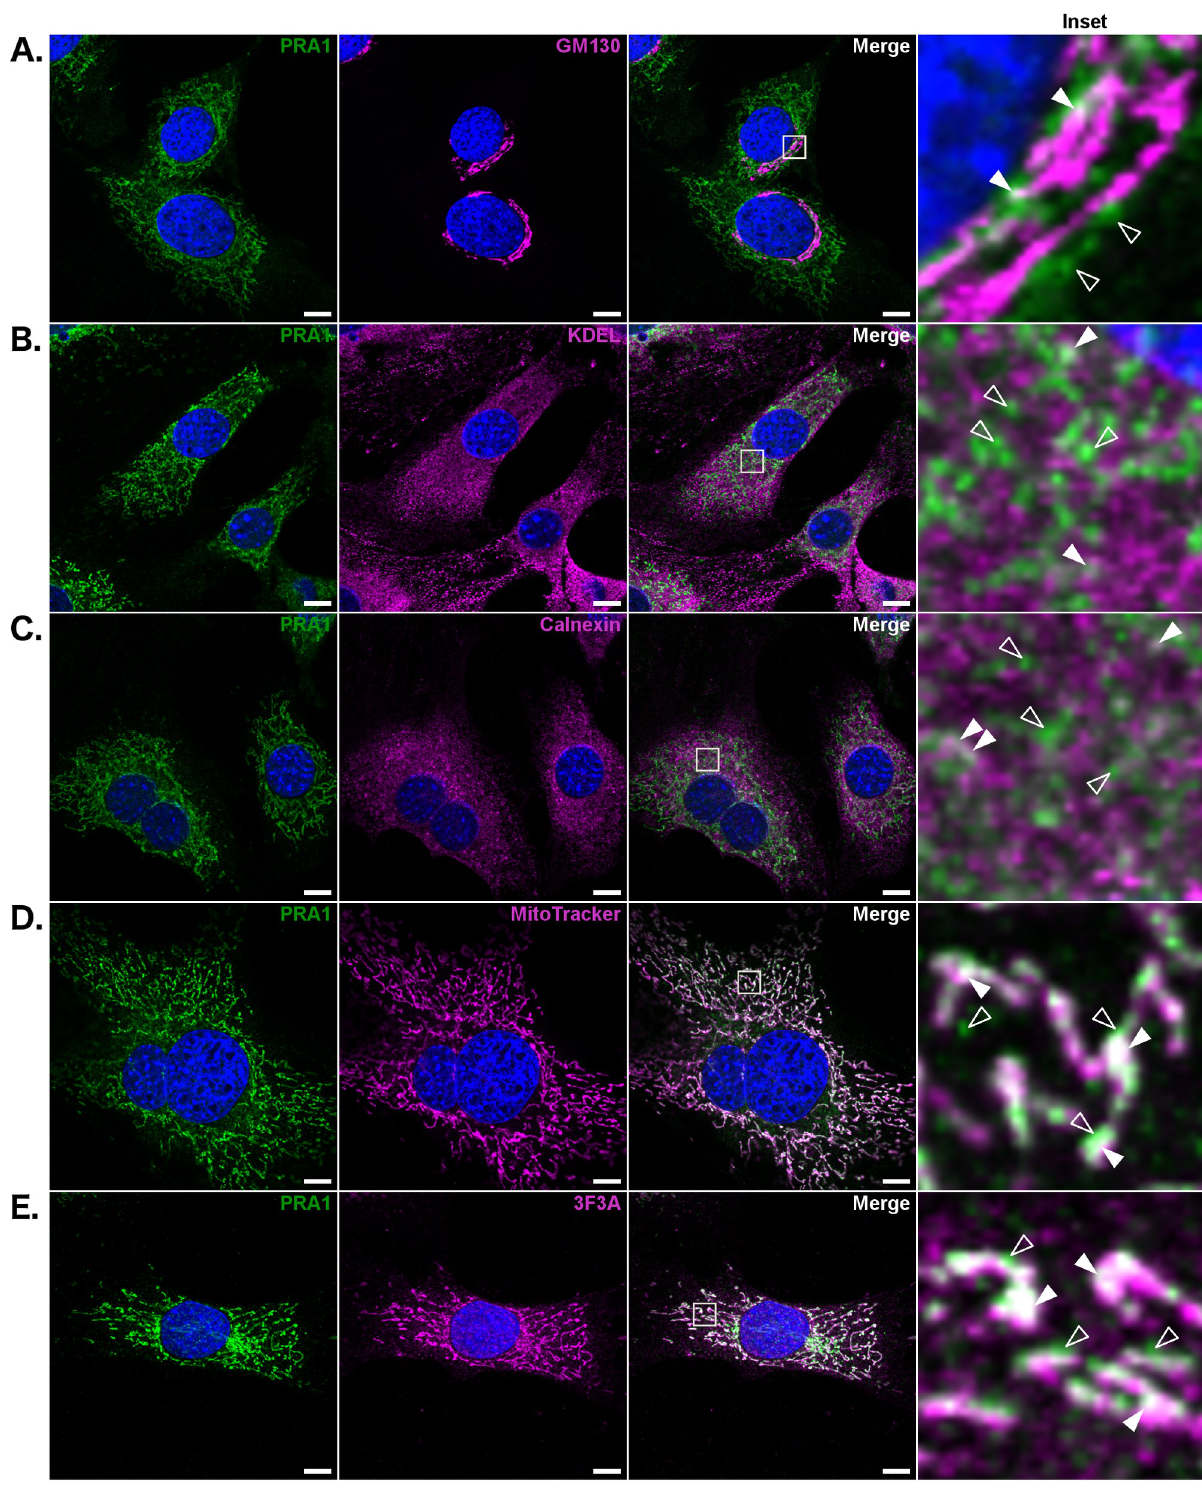
Fig 2. A subpopulation of endogenous PRA1 is localized to Gp78/AMFR positive ER-mitochondria membrane contact sites in NIH3T3 cells. PRA1 was co-stained with (A) GM130, (B) KDEL, (C) Calnexin, (D) MitoTracker, and (E) Gp78/AMFR (3F3A antibody). Solid arrowheads denote regions of co-localization; empty arrowheads denote regions of independent PRA1 localization. Images are representative of at least three acquisitions and are compiled from a 1 μ m z-section. Insets are ten-fold magnifications of an area within the displayed images, highlighted with a solid-line. Scale bar: 10 μ m. Green: PRA1, Magenta: Organelle specific marker, Blue: Nuclear labeling via DAPI, White: Co-localization. https://doi.org/10.1371/journal.pone.0243075.g002 PLOS ONE | https://doi.org/10.1371/journal.pone.0243075 December1,